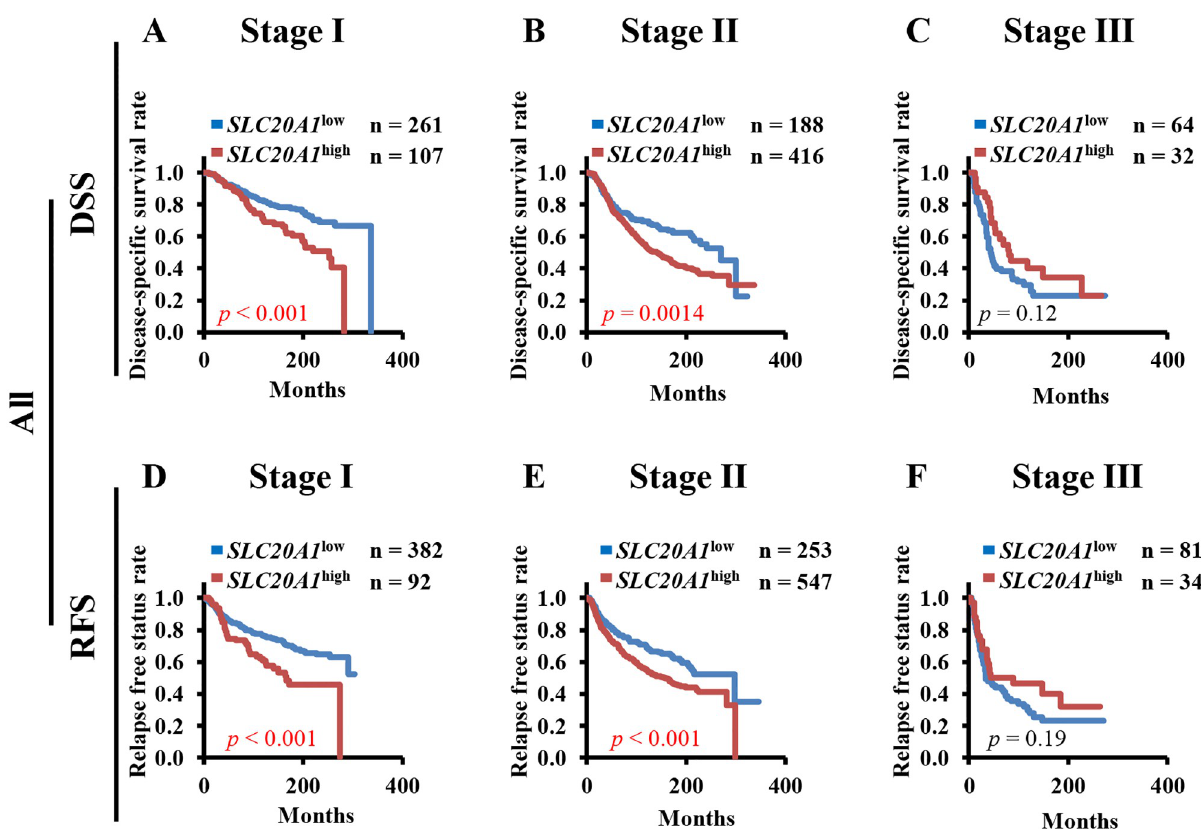
Fig 1. Patients with high solute carrier family 20 member 1 (SLC20A1) expression ( SLC20A1 high ) have poorer clinical outcomes at early tumor stages. (A-F) Kaplan-Meier analyses comparing the disease-specific survival (DSS) and relapse-free status (RFS) in all patients with breast cancer between those in the SLC20A1 high and low SLC20A1 expression ( SLC20A1 low ) groups. (A) DSS in tumor stage I. (B) DSS in tumor stage II. (C) DSS in tumor stage III. (D) RFS in tumor stage I. (E) RFS in tumor stage II. (F) RFS in tumor stage III.